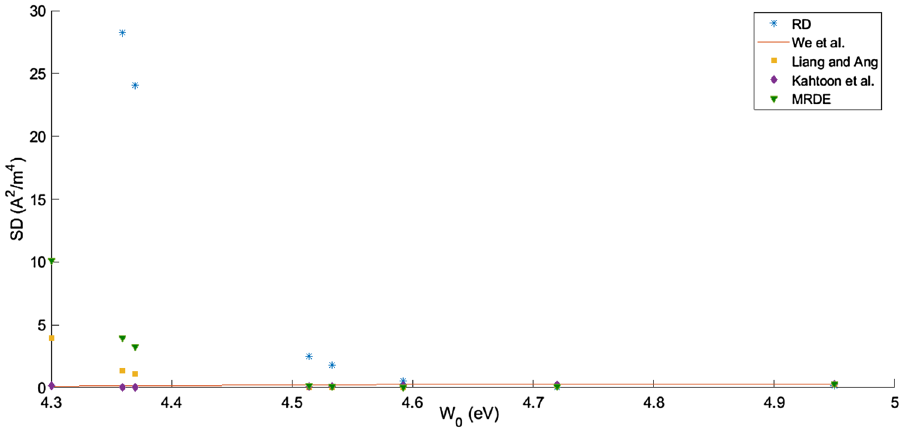
2 / m 4 ) Figure 2. SD ( A against the work function (eV) of five models in